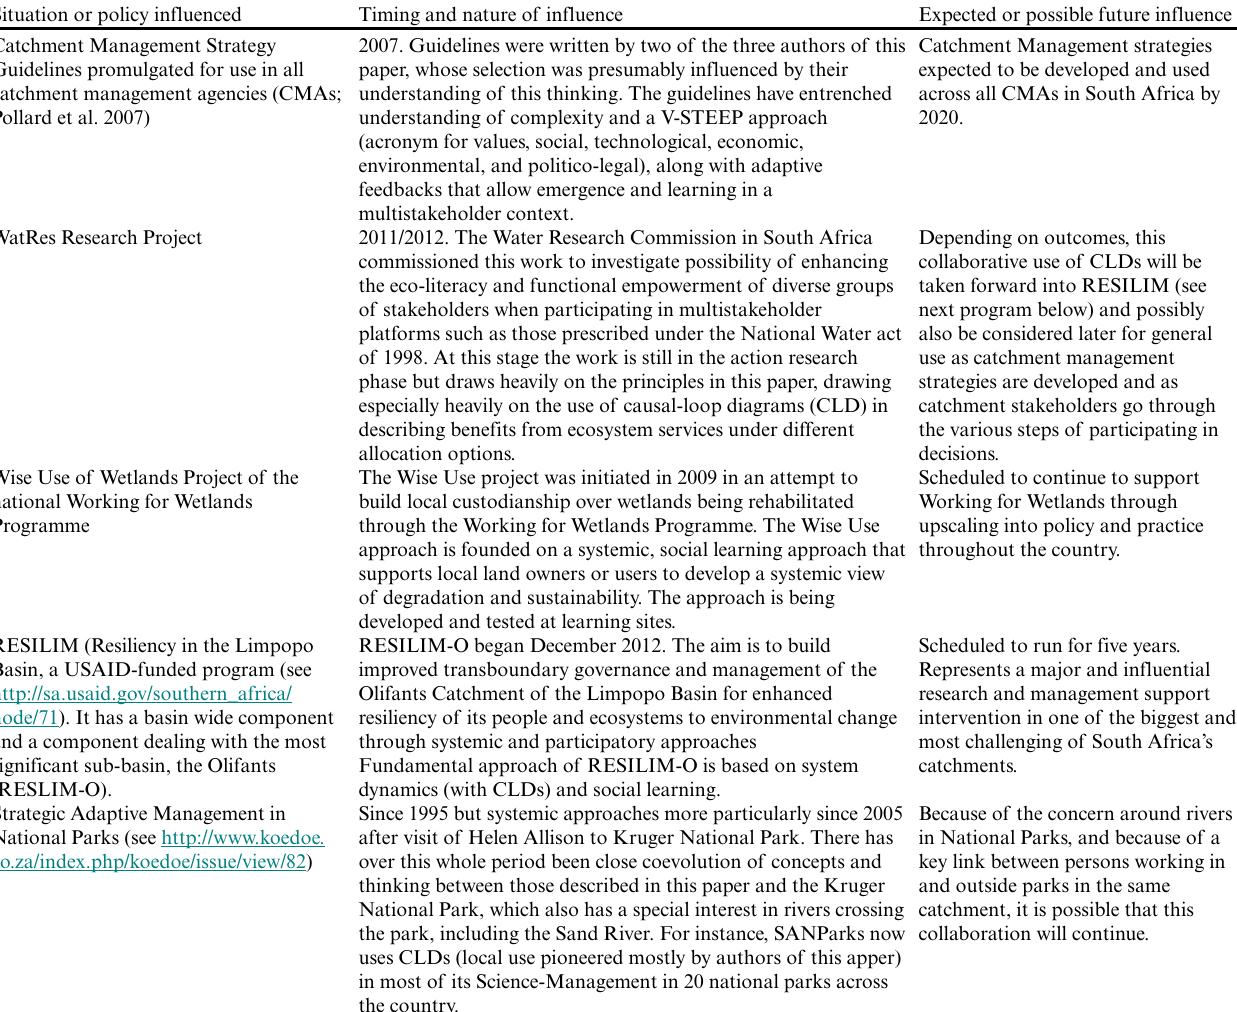
Table 2 . Recent examples of how the thinking developed in this paper has influenced, or is potentially likely to influence, policy change and implementation regarding water and livelihood security in catchments in South Africa. The work was initially described in a detailed report (Pollard et al. 2008) by which time some of the initiatives below had already begun. Many other factors and influences often also contributed to these